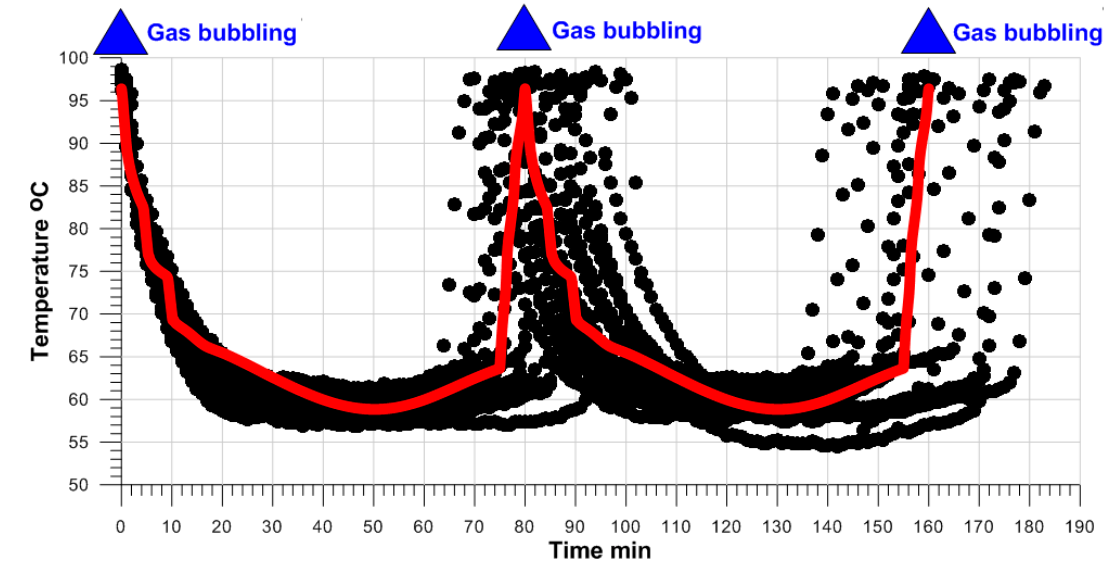
Figure 12. Modeling (run #9A2, unknown parameter estimations were: q = 0.15 kg/s, h = 84 kJ/kg (water 20 °C), Q = 2 kg/s)) of the transient bottom temperature in the Shaman geyser vs. the bottom temperature records obtained during the time period of observations from 27.06.2019 18:00 to 29.06.2019 18:00 (Figure 5).